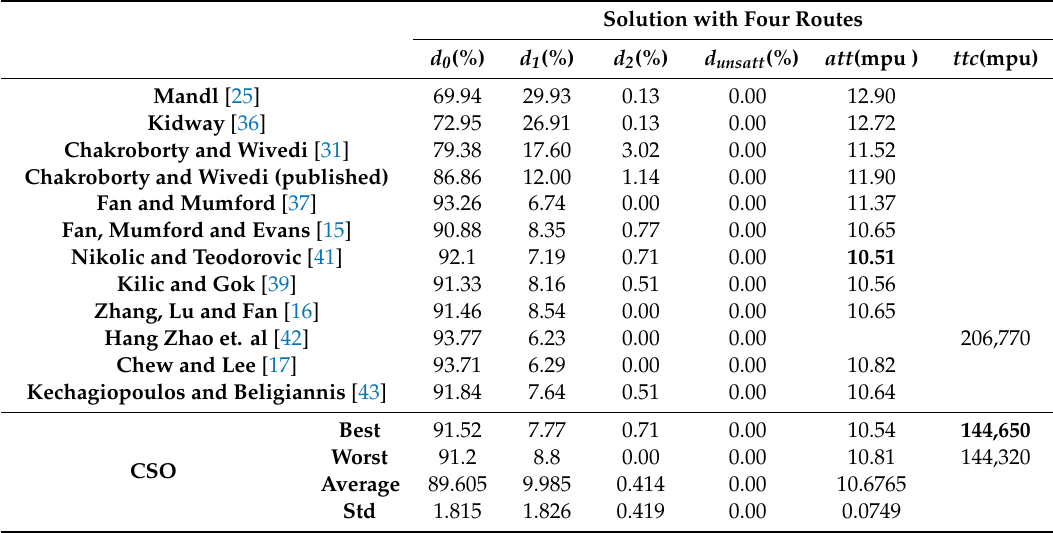
Table 5. Comparative results for the best four-route solutions for Mandl’s network.